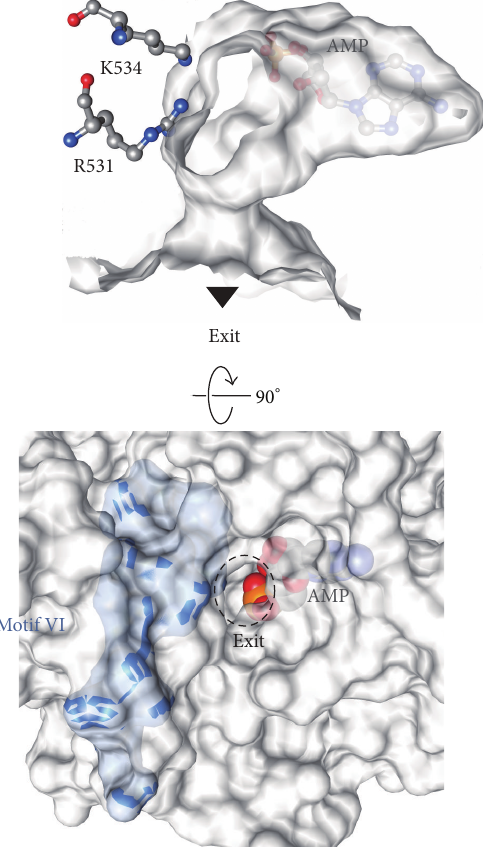
Figure 11: Top: the AMP-binding pocket viewed from the inside of the molecule. A solvent-accessible surface was created without the bound AMP, and then the final refined AMP model was superimposed. The noncovalently bound AMP is trapped within a closed compartment, which conforms well to the shape of the AMP molecule. Bottom: surface representation around the hole in the activesitepocket.ThesurfaceofmotifVIiscoloredcyan.Thebound AMP is depicted as a sphere model. The phosphate (phosphorus, orange; oxygen, red) group is visible through a small